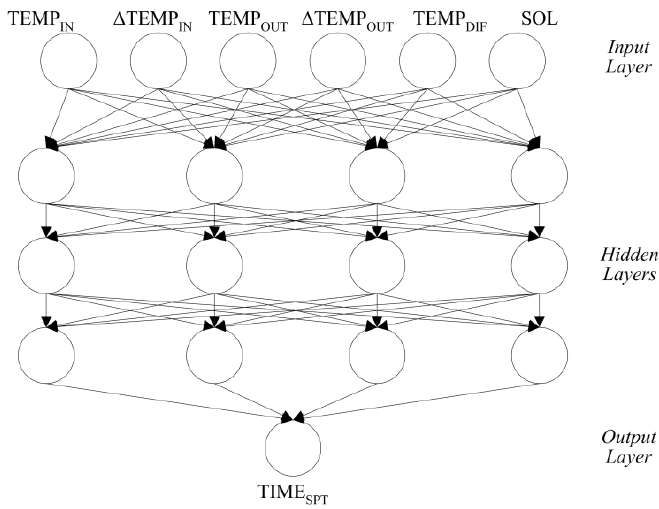
Figure 3. The initial ANN model.